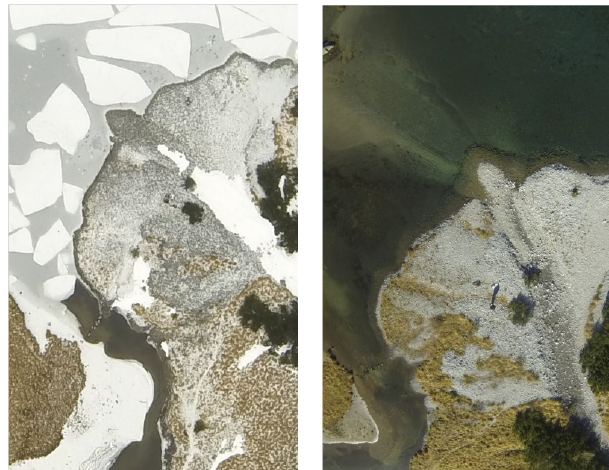
Figure 9. Deluvio-fluvial sediments depositing ˇCierne Javorové alpine lake in winter 2014 (on the left) and in summer 2013 (on the